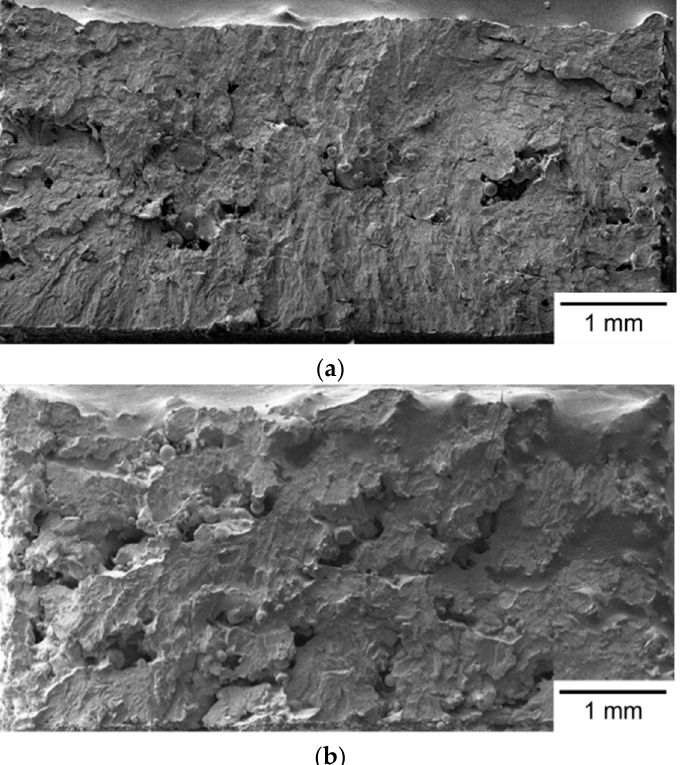
Figure 6. Fracture surface of ( a ) a Group S3 specimen and ( b ) a Group S4 specimen observed by SEM.